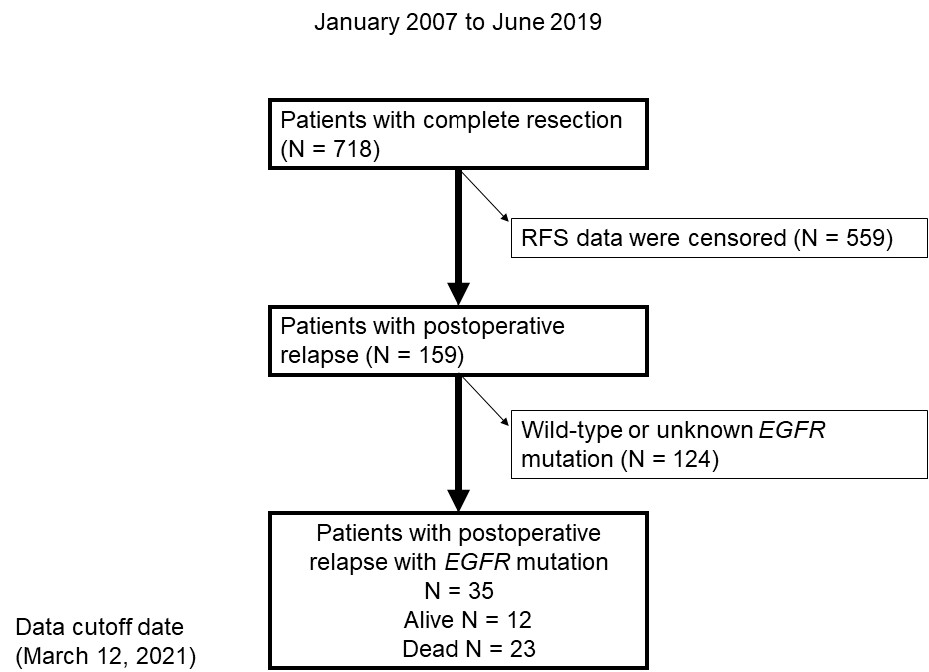
Figure 1. Flow chart demonstrating the identification of patients with postoperative relapse of NSCLC with EGFR mutation between January 2007 and June 2019. RFS, relapse-free survival.